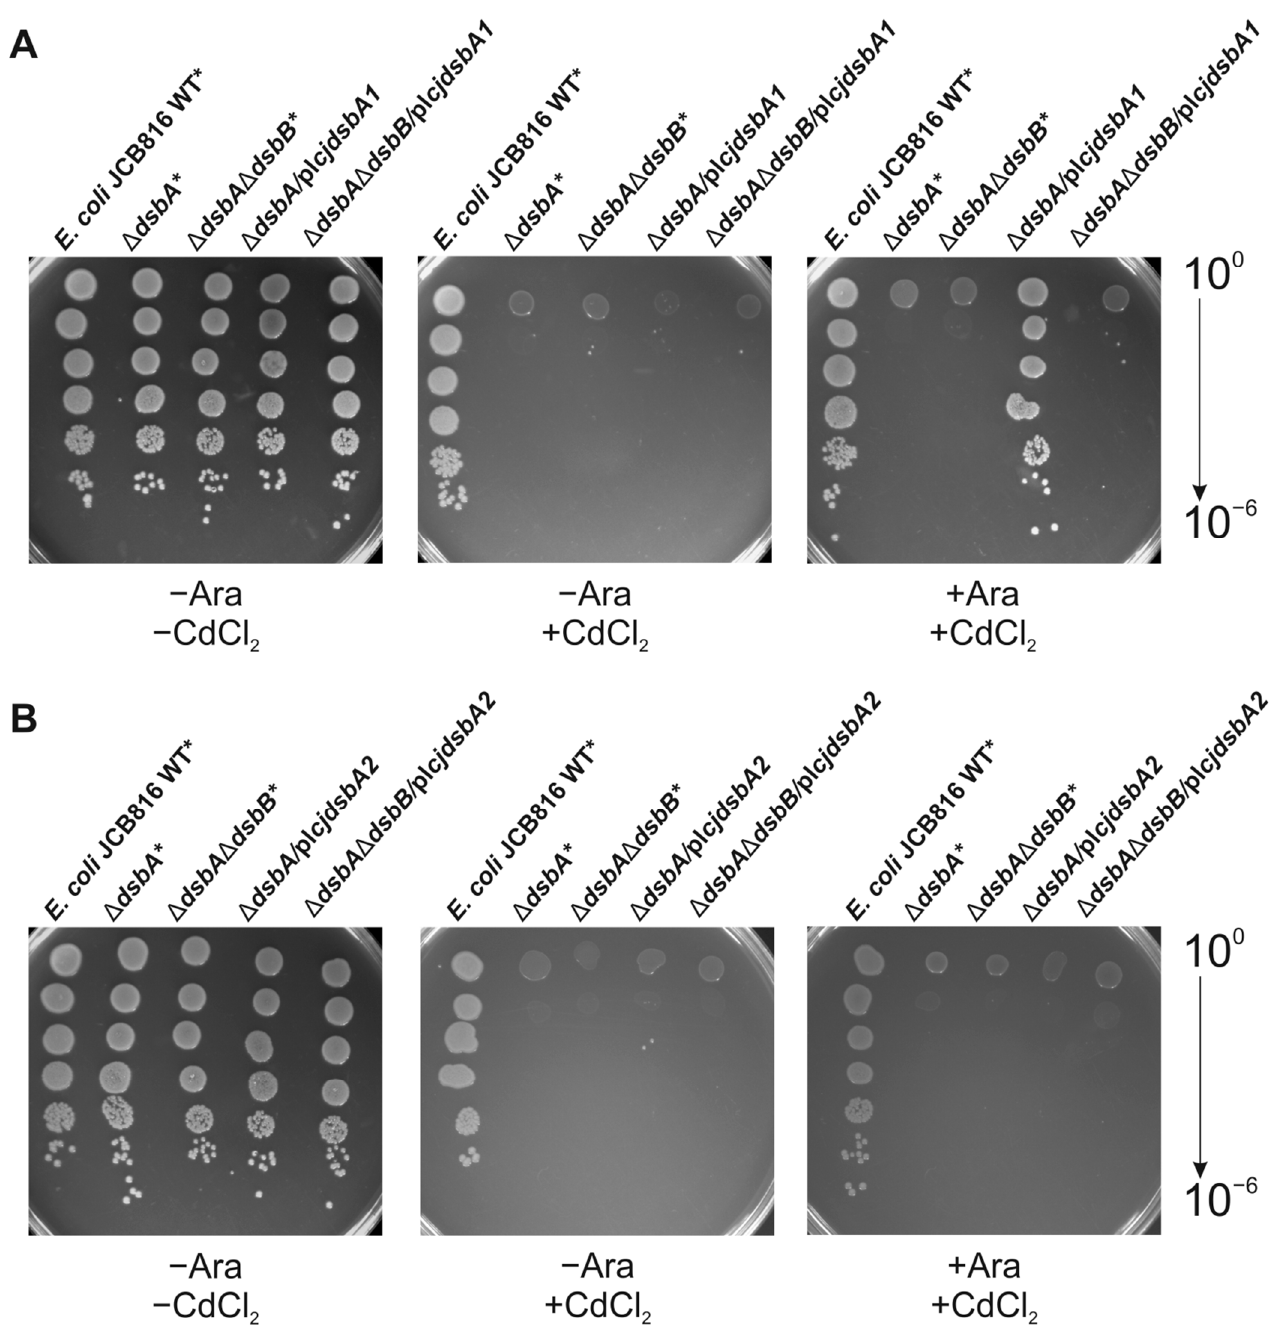
Figure 4. CjDsbA1 ( A ), but not CjDsbA2 ( B ), complemented lack of DsbA in DsbB-dependent manner in cadmium sensitivity assay in E. coli cells. E. coli strains: JCB816 (wild-type), JCB817 ( ∆ dsbA ), JCB818 ( ∆ dsbA ∆ dsbB ), carrying pMPM-A6 plasmid (*), and ∆ dsbA /pl cjdsbA1 , ∆ dsbA ∆ dsbB /pl cjdsbA1 , ∆ dsbA /pl cjdsbA2 , ∆ dsbA ∆ dsbB /pl cjdsbA2 in exponential growth phase were serially diluted and spotted onto LB plates supplemented with 0.2% arabinose (+Ara) and 40 µ M CdCl 2 and incubated for 18 h at 37 ◦ C. As controls, we used plates without arabinose ( − Ara) or CdCl 2 . Three independent experiments were performed ( n = 3). The figure presents a representative result.